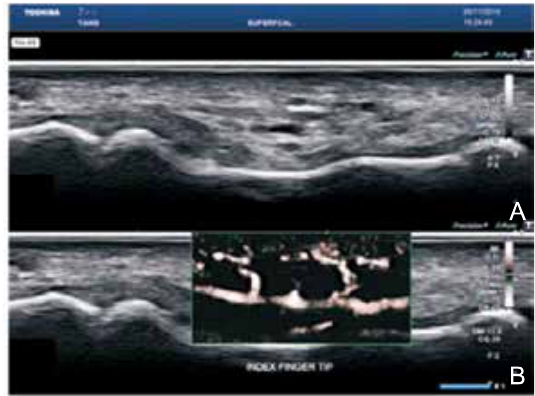
Figure 4 High resolution ultrasound (A) and advanced dynamic flow (B) are demonstrated with the examination of the distal end of an index finger. Image provided by Cannon Medical Systems.